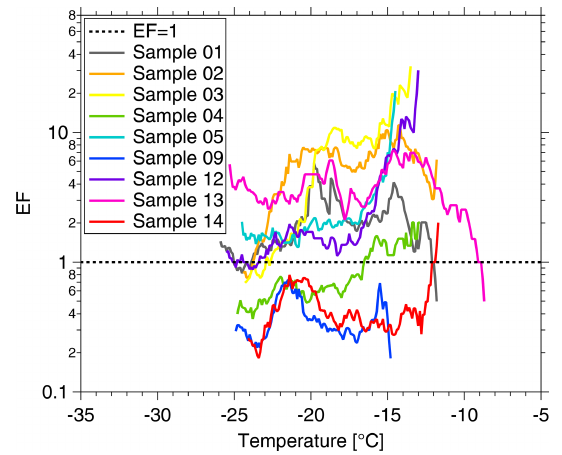
Figure 2. Enrichment factor (EF) as a function of ice-nucleation temperature. The EF = 1 result is shown by the dashed